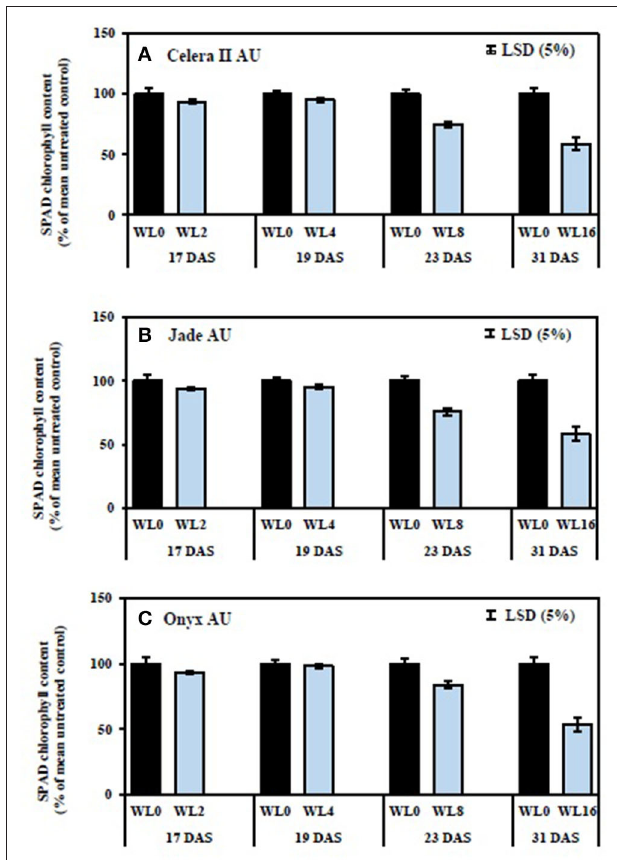
FIGURE 7 | Relative chlorophyll content (SPAD readings of the first trifoliate leaf) under different waterlogging durations for (A) Celera II-AU, (B) Jade-AU, and (C) Onyx-AU. The percentage of SPAD chlorophyll content for WL plants was estimated relative to their drained controls. WL0, drained control; WL2, WL for 2 days, harvested at 17 DAS; WL4, WL for 4 days, harvested at 19 DAS; WL8, WL for 8 days, harvested at 23 DAS; WL16, WL for 16 days, harvested at 31 DAS. The average SPAD chlorophyll content in the drained control is 41 ± 3 in Celera II AU, 50 ± 3 in Jade AU, and 44 ± 3 in Onyx AU. Data are means ± SE of four replicate pots. Vertical bars are LSD at P = 0.05 for the genotype.